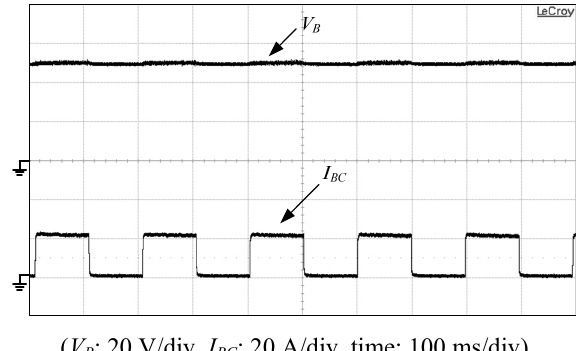
Figure 23. Measured charge voltage V the repeat period of 200 ms, duty ratio of 0.5 and peak charging current of 20 A.